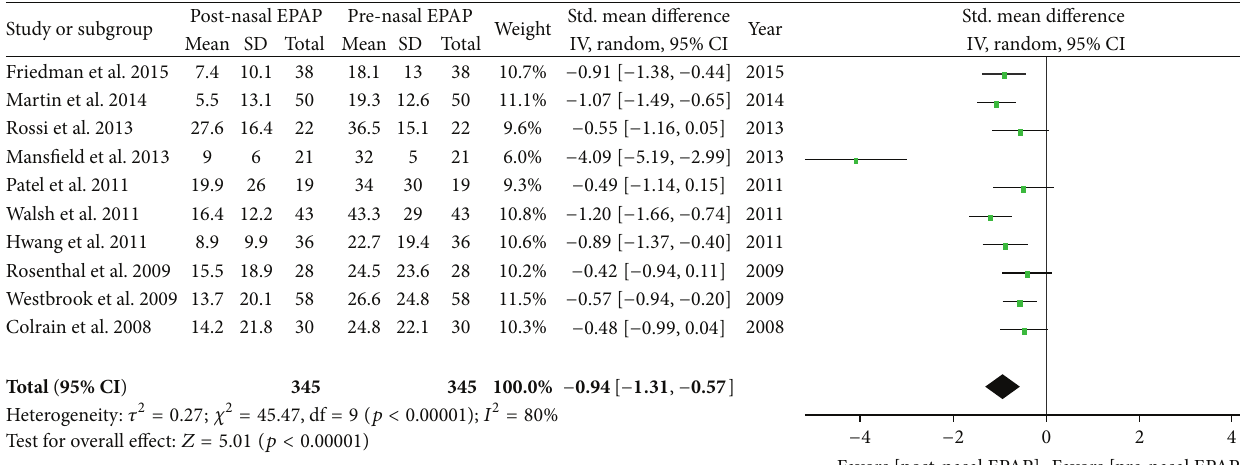
For all 345 patients, the AHI standardized mean difference (SMD) was − 0.94 [95% CI − 1.31, − 0.57] (large magnitude